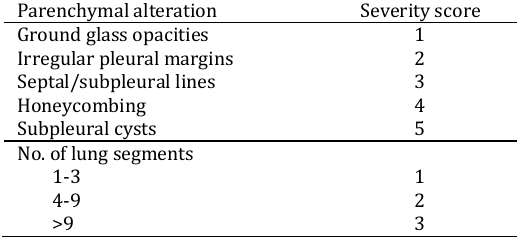
Table 2. The Warrick score in scleroderma lung fibrosis according to lung HRCT findings Parenchymal alteration Severity score Ground glass opacities